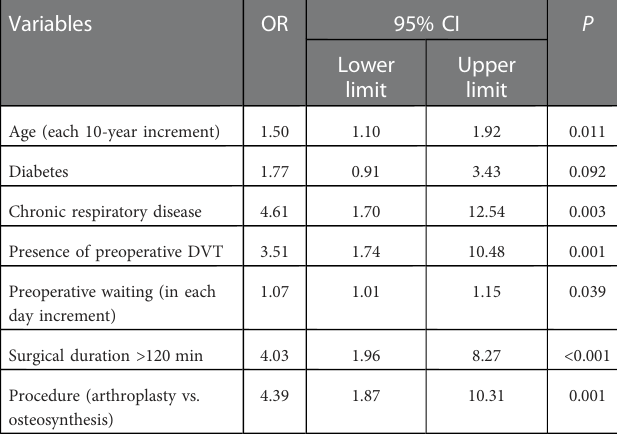
TABLE 2 Multivariate analysis of factors associated with postoperative nosocomial pneumonia in patients with a hip